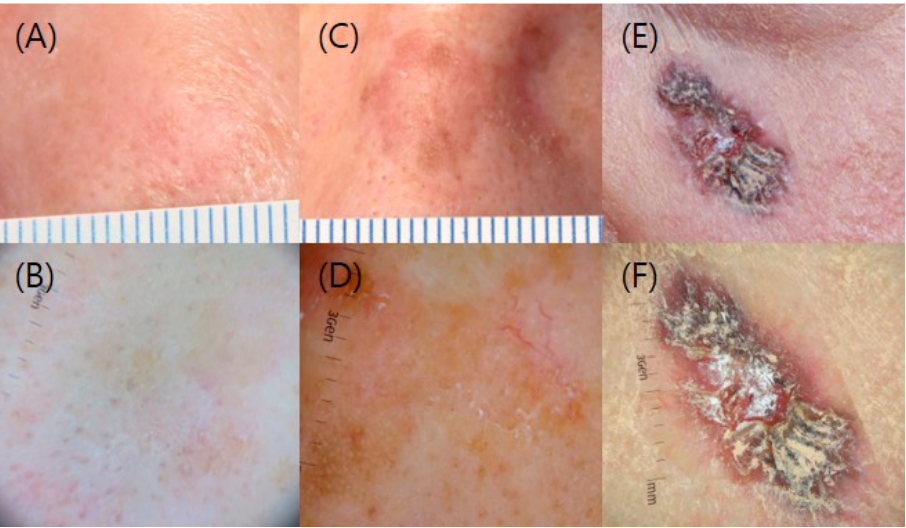
Figure 1. Clinical and dermoscopic grading of AK. ( A , B ) Grade 1; ( C , D ) Grade 2; and ( E , F ) Grade 3.